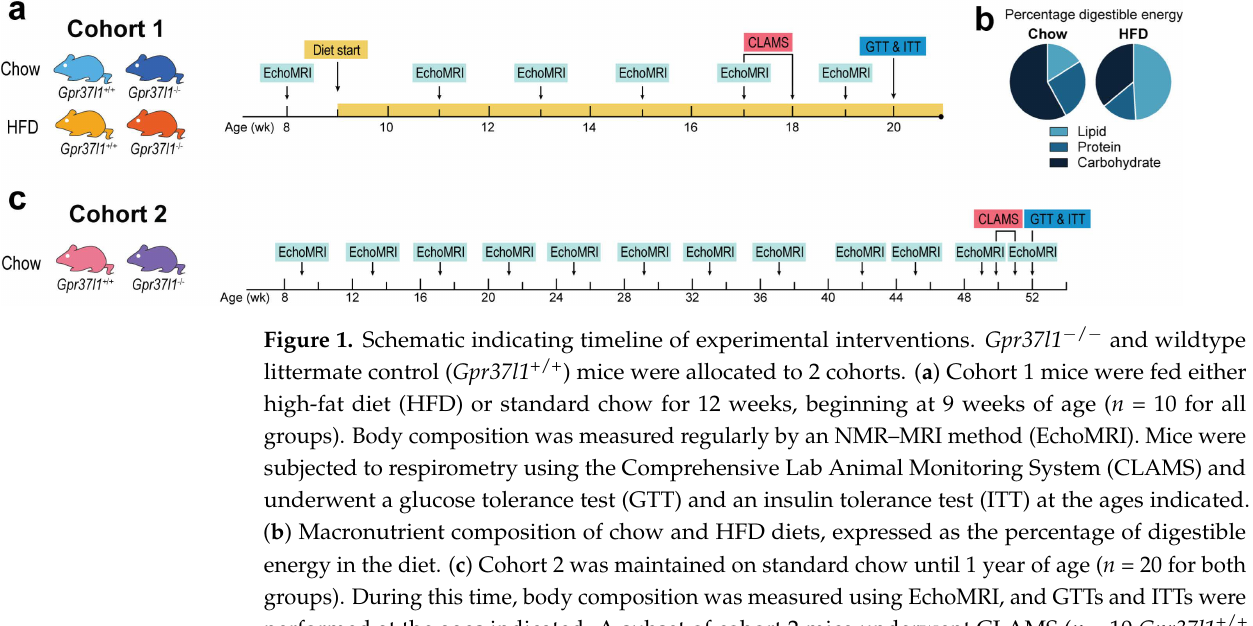
(Supplementary Figure S1) and Gpr37l1 +/+ and Gpr37l1 − / − mice allocated into cages of